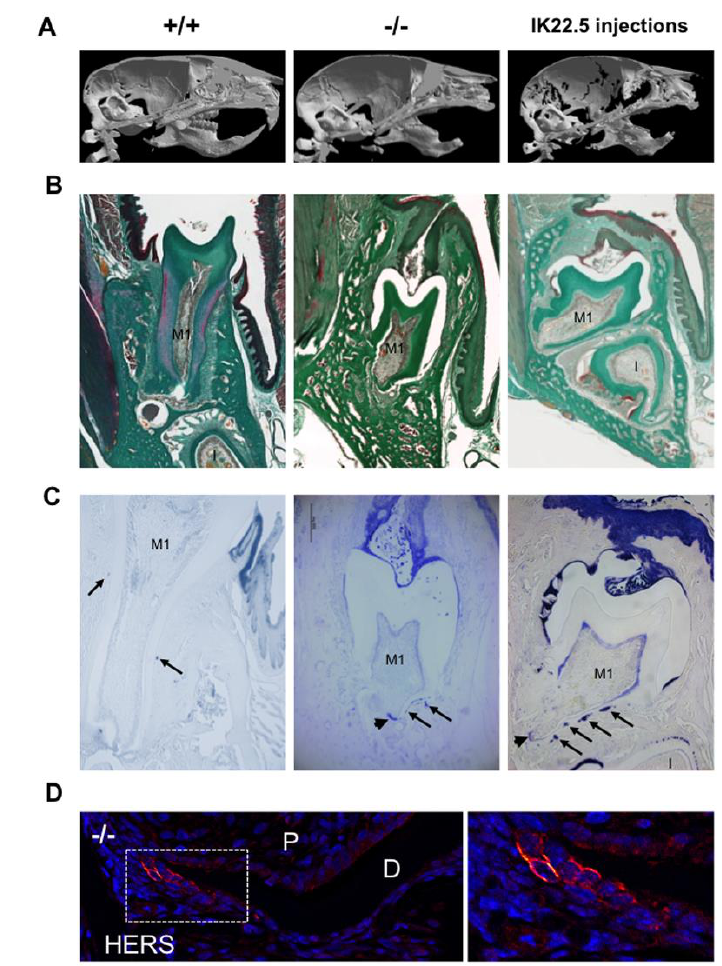
Figure 5. Comparative analyses in 35-day-old mice on the consequences on dental phenotype of the global ( Rankl - / - ) versus transient (4 injections of IK22.5 neutralizing antibody from postnatal days 1 to 7) invalidations of RANKL. At least five mice were analyzed for each group. ( A ) Micro-tomography 3D reconstructions of the heads of Rankl +/+ , Rankl - / - and RANKL transiently invalidated mice made it possible to observe similar phenotypes between the RANKL invalidated mice compared to the controls ( Rankl +/+ ), with the presence of a more curved skull associated with dental eruption defects. ( B ) Masson’s trichrome staining carried out on frontal sections in the plane of the first molar (M1) of Rankl +/+ , Rankl - / - and RANKL transiently invalidated mouse heads confirmed the defective eruption and evidenced similar dysmorphic lower molars for the RANKL-invalidated mice in comparison to the controls. However, a more pronounced phenotype was visible for the global invalidation, with the presence of ankylosis in the buccal region. Interestingly, the incisor (I) was absent in this section’s plane only for the mouse globally invalidated for RANKL. Scale: 20X / 100 µ m. ( C ) The keratin-14 immuno-labeling evidenced the presence of HERS cells and hypertrophic epithelial rests of